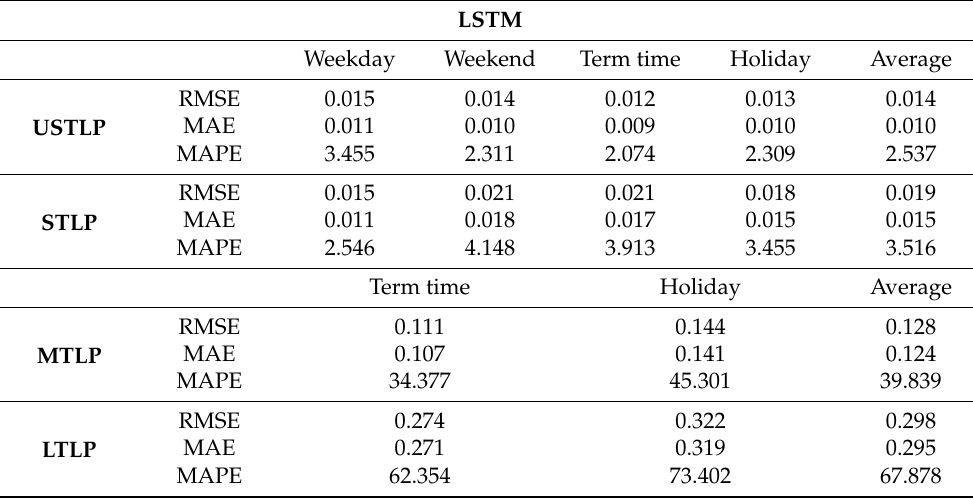
Table 5. Model metric for two algorithms in various